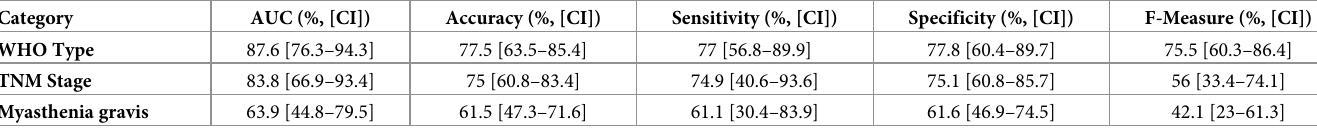
Table 2. Random forest classifier